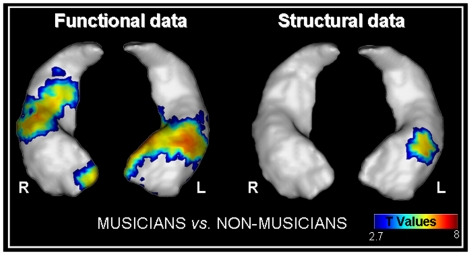
Functional and structural differences between musicians and nonmusicians.Contrasts are displayed at p<0.005 (uncorrected) and rendered onto a hippocampus mesh using Anatomist software (www.brainvisa.info). Abbreviations: L = left hemisphere, R = right hemisphere.